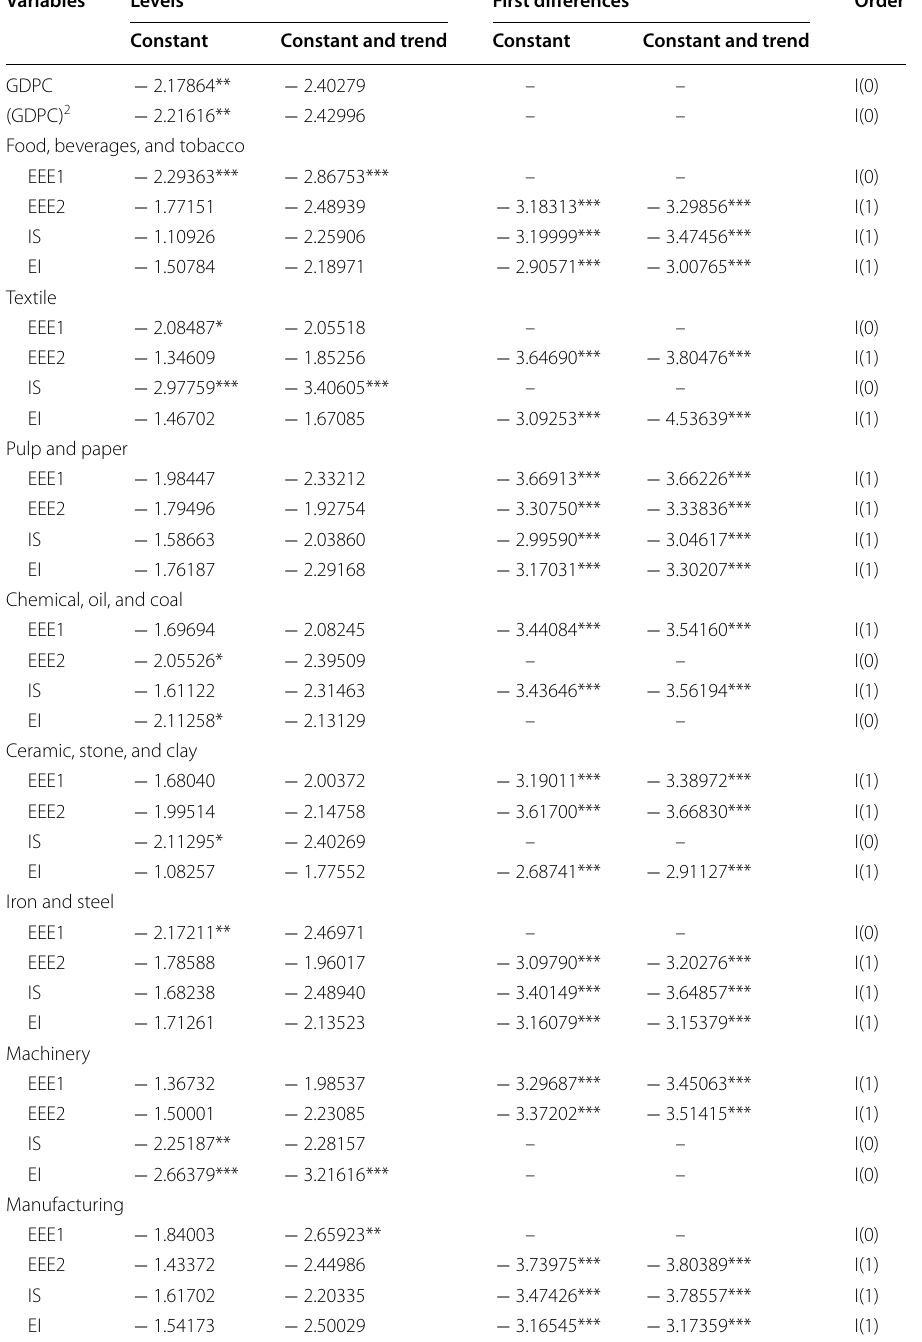
Table 5 CIPS panel unit root